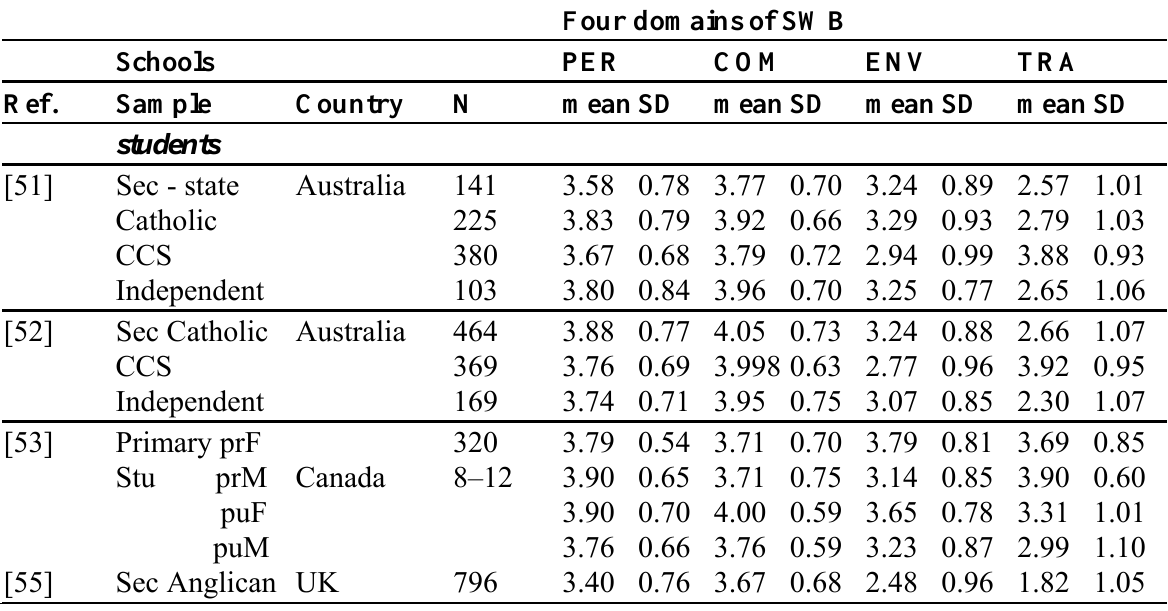
Table 2. SWB levels among school students and staff using the